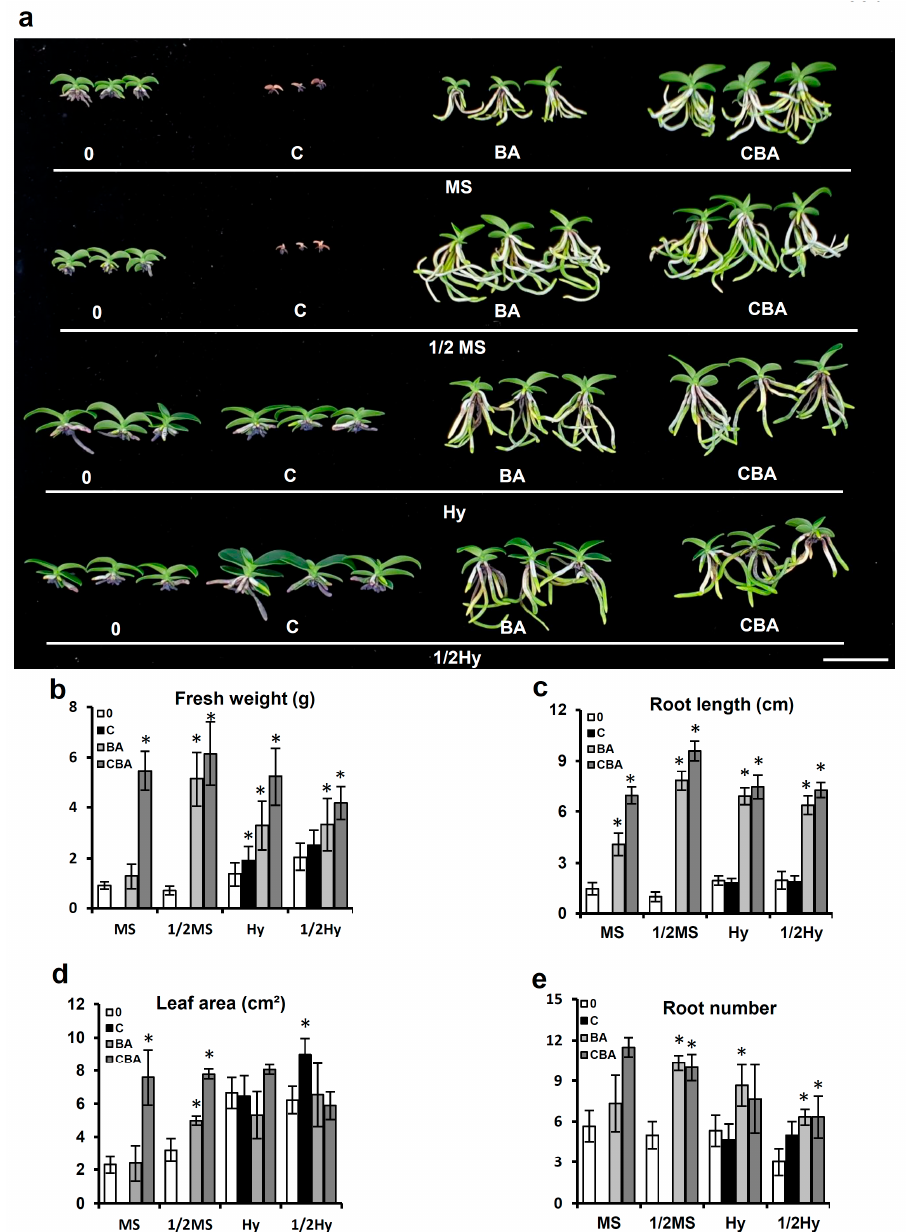
Figure 5. Effect of different medium on plant growth at the later stage of Sedirea japonica . ( a ) Growth differences in seedlings were determined nine months after sowing. The pictures show a representative seedling of each medium. Fresh weight ( b ), root length ( c ), leaf area ( d ), and root number ( e ) were measured. Scale bar = 2 cm. C: activated charcoal; BA: banana and apple homogenates; MS: full-strength MS; 1/2MS: half-strength MS; Hy: full-strength Hyponex; 1/2Hy: half-strength Hyponex. Data are shown as mean ± SD of the values obtained from triplicate experiments. * p ≤ 0.05.